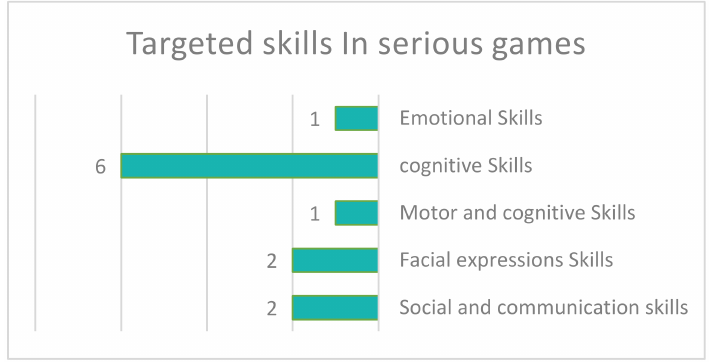
Figure 16. Targeted skills in serious